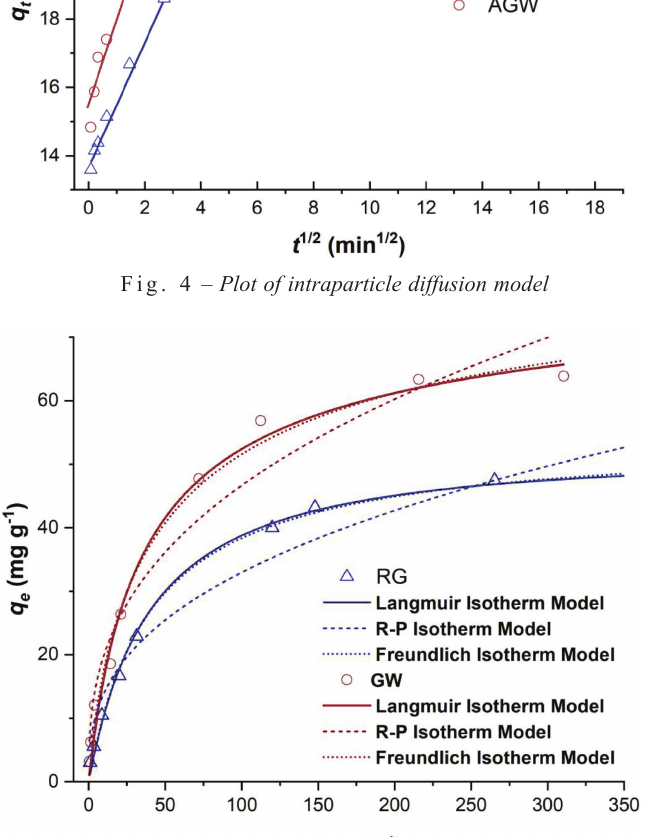
Fig. 5 – Equilibrium adsorption isotherm modeling for GW and AGW (T = 30 °C, pH = 6.6±0.1, V = 100